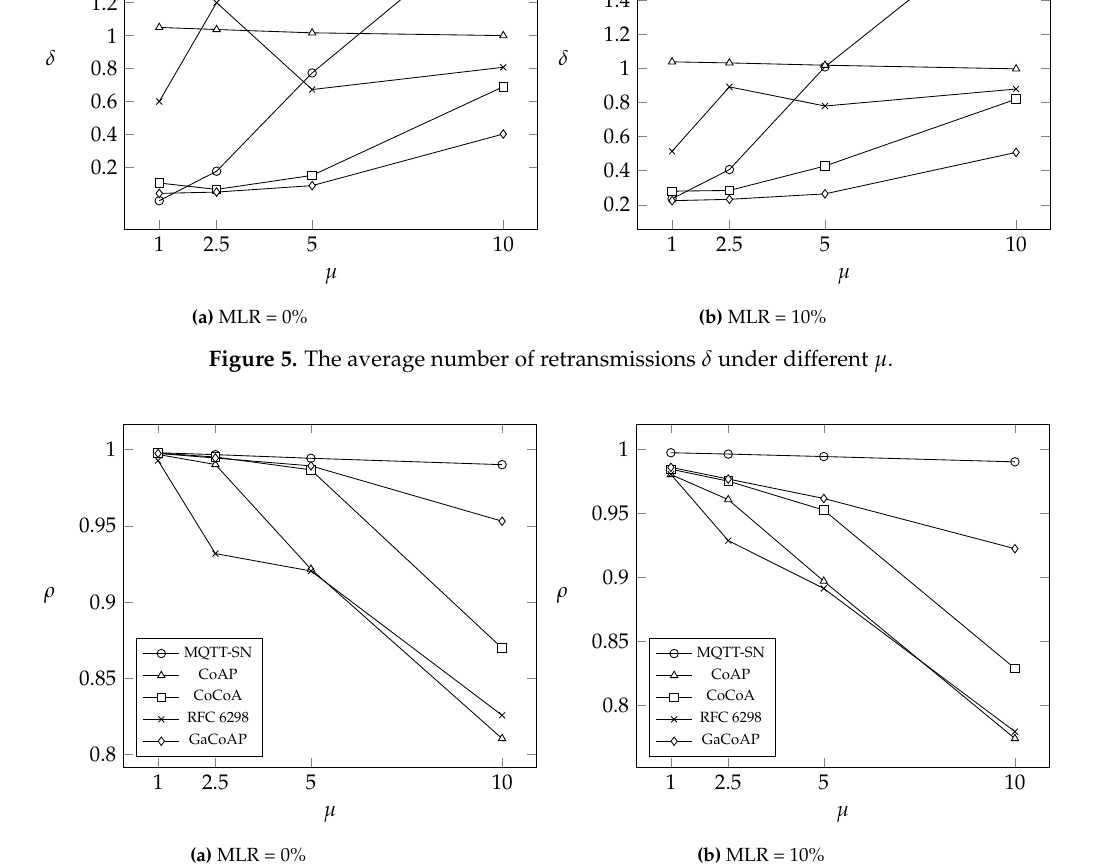
Figure 6. The average message delivery ratio ρ of device under different µ .